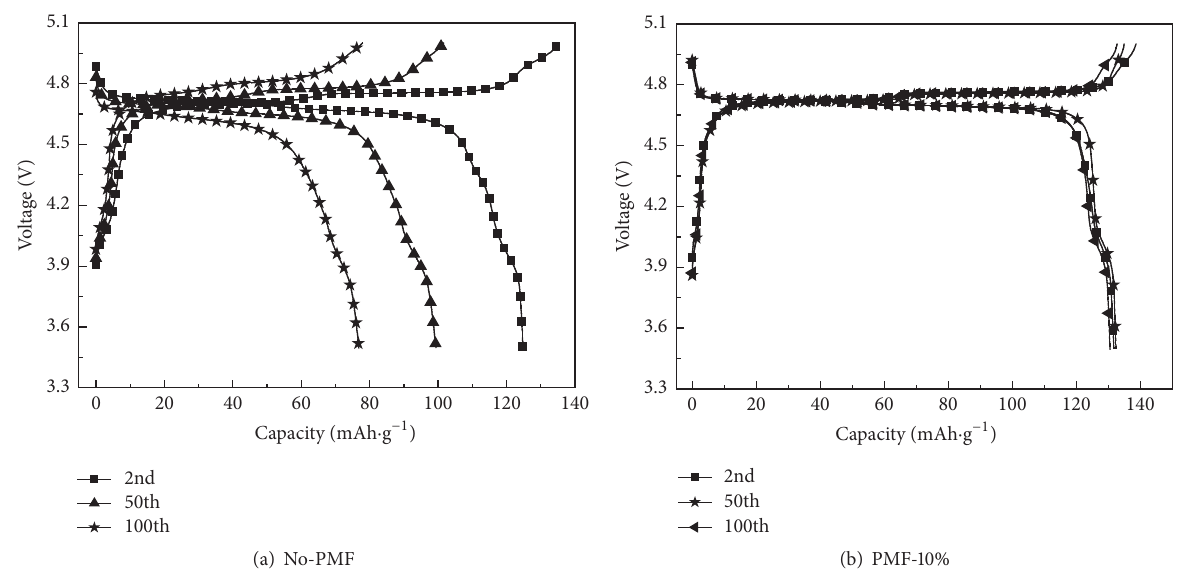
Figure 3: The charge and discharge curves of prepared LiNi 0.5 Mn 1.5 O 4 at 0.5